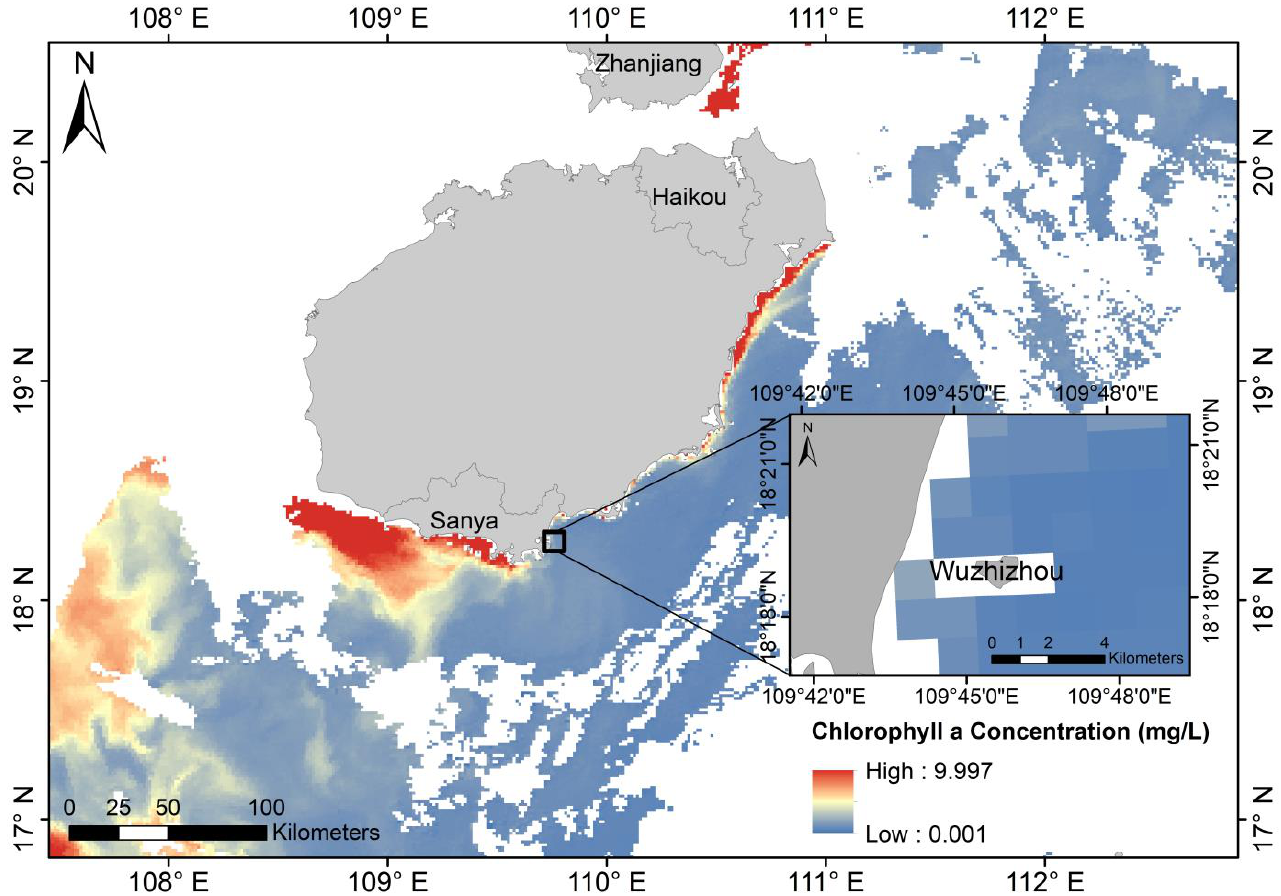
Figure 14. Chlorophyll a concentration in the water around Wuzhizhou Island on 8 April 2018.